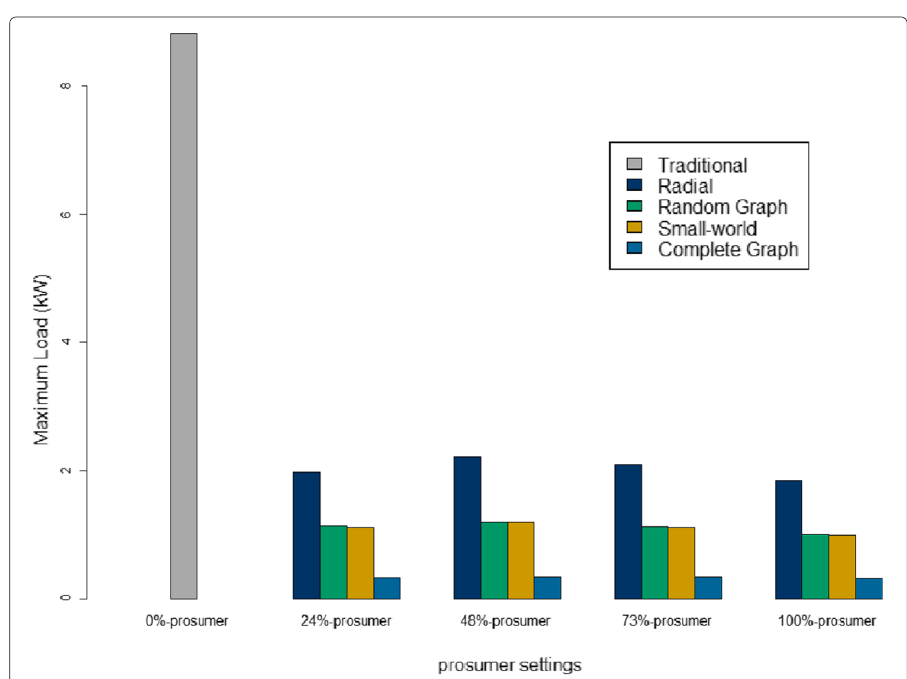
Fig. 5 Maximum load of the distribution network